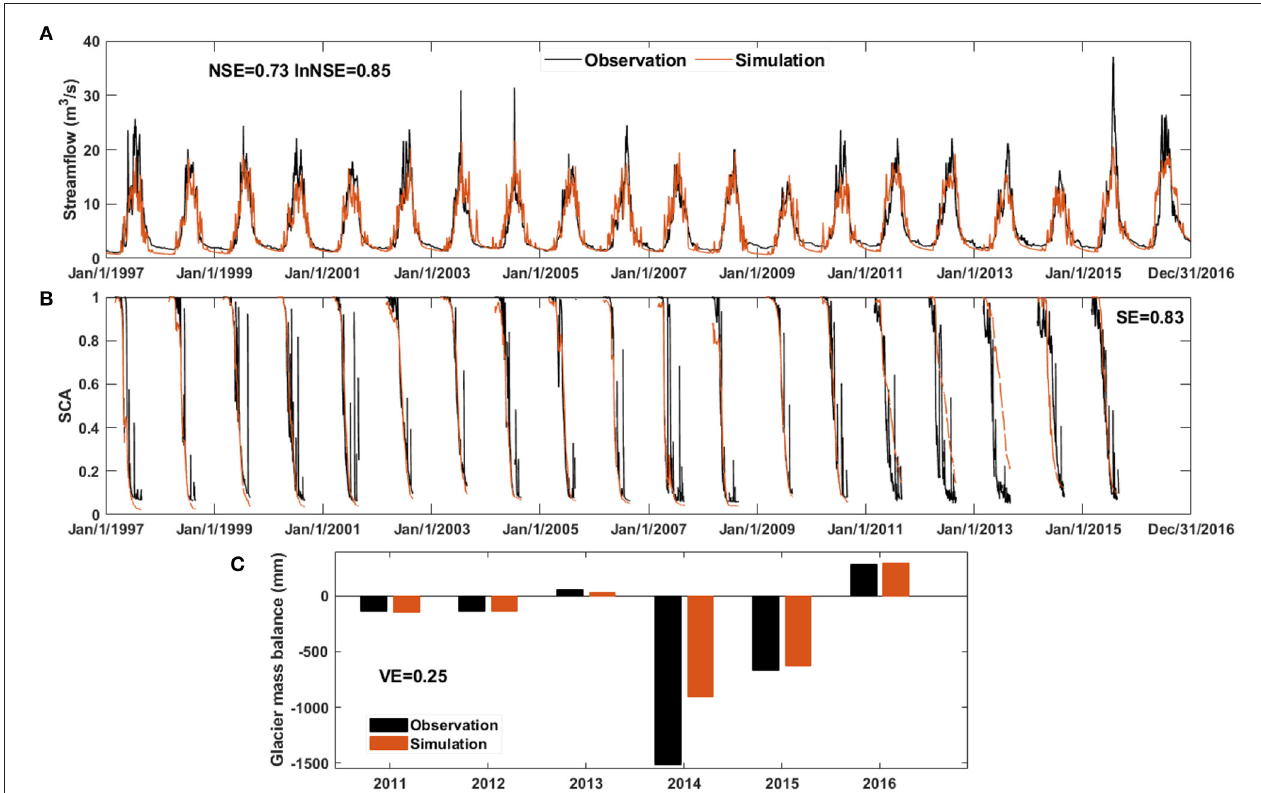
FIGURE 2 | Model performance for the simulations of streamflow (A) , snow cover area (B) , and annual glacier mass balance (C) in the evaluation period of 1997–2016.